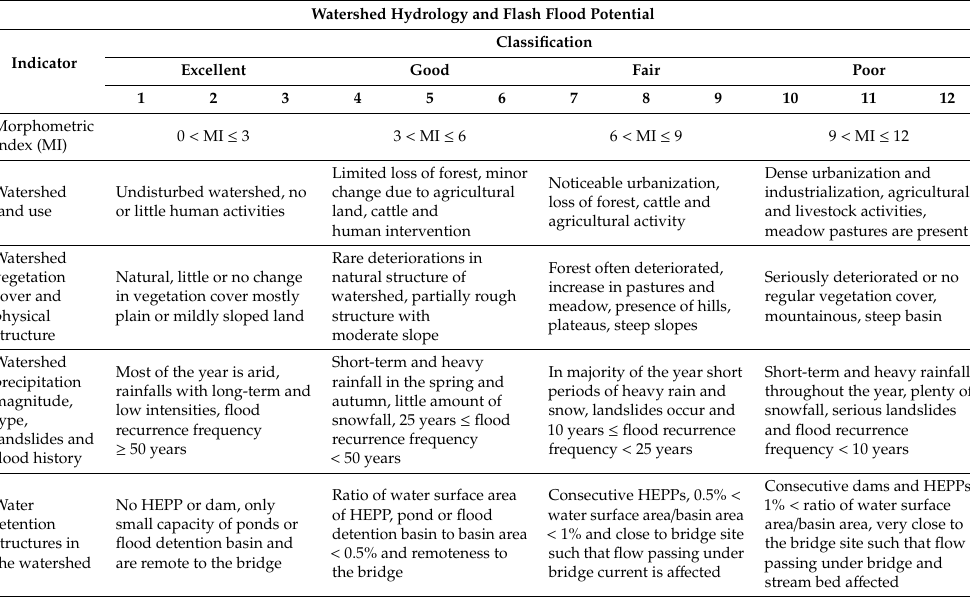
Table 2. Assessment of watershed hydrology and flash flood potential